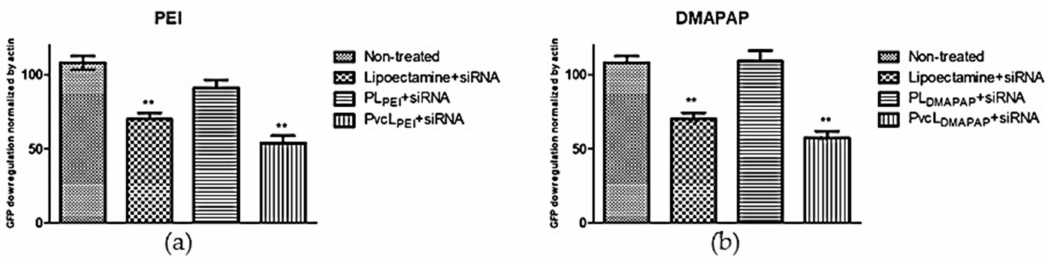
Figure 6. Quantitative analysis of GFP downregulation (normalize by actin) with siRNA encapsulated in cationic formu- lations. ( a ) Non-treated lipofectamine, PL PEI , and PvcL PEI , ( b ) non-treated lipofectamine, PL DMAPAP , and PvcL DMAPAP treated cells. Student’s t -test was applied, p < 0.05 (**) for PvcL PEI , lipofectamine, and PvcL DMAPAP formulations ( n = 3).